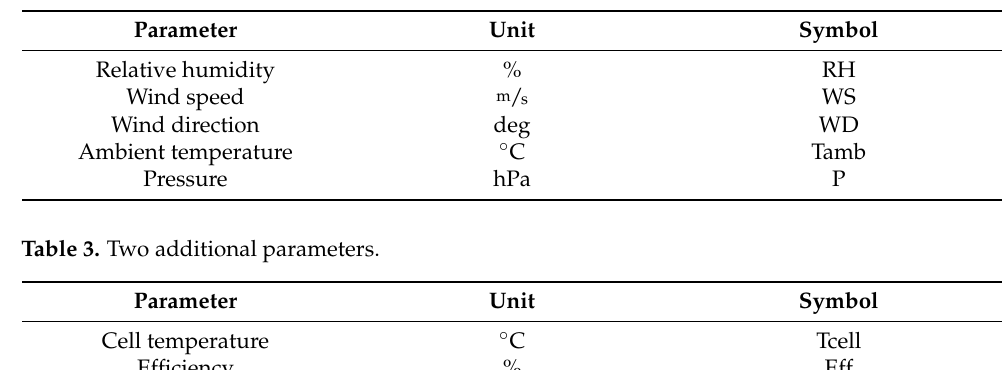
Table 2. Meteorological parameters.